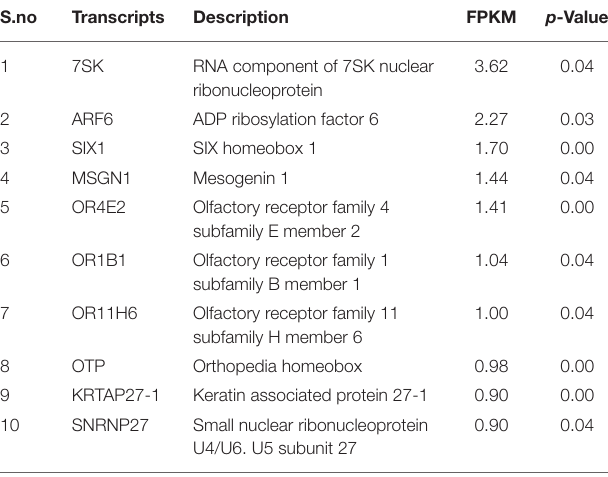
TABLE 5 | Top 10 abundantly expressed transcripts unique to poor-quality